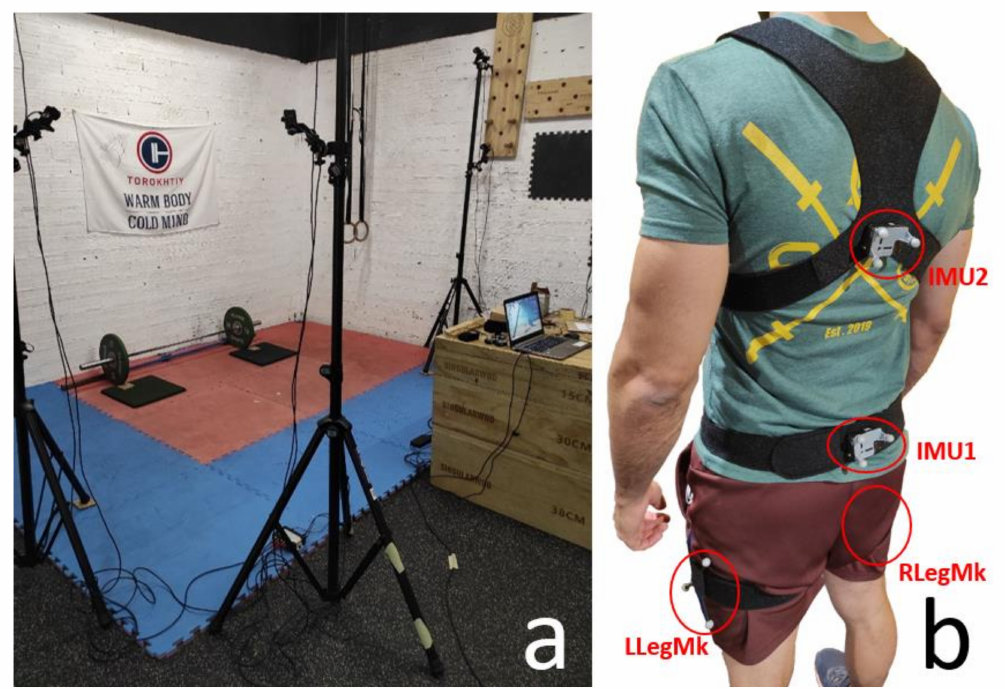
Figure 8. ( a ) Portable motion capture system. ( b ) Configuration of